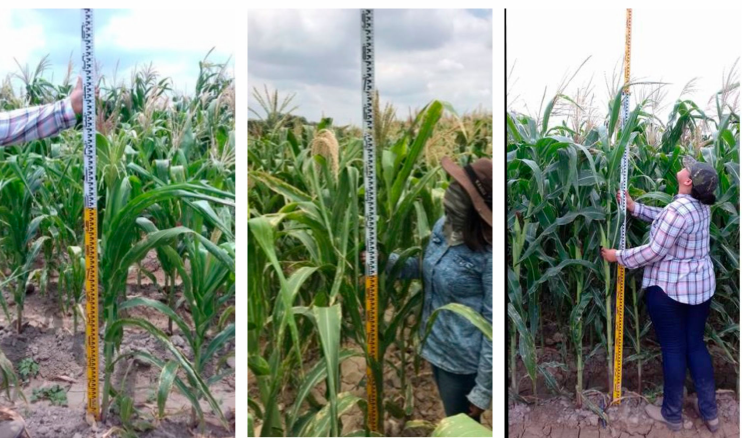
Figure 4. Selection of plants of the average height of the experimental unit by